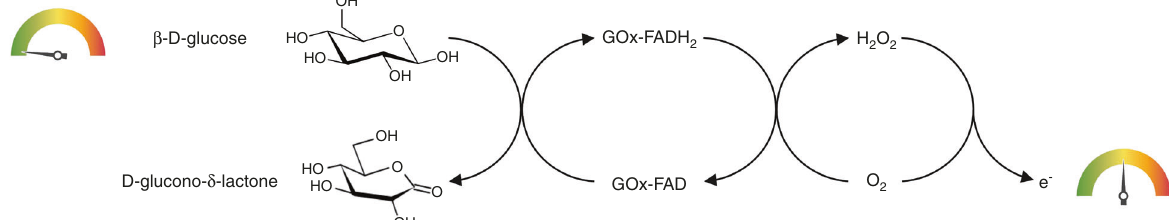
Fig. 9 The enzymatic oxidation of glucose produces hydrogen peroxide whose concentration is directly proportional to that of